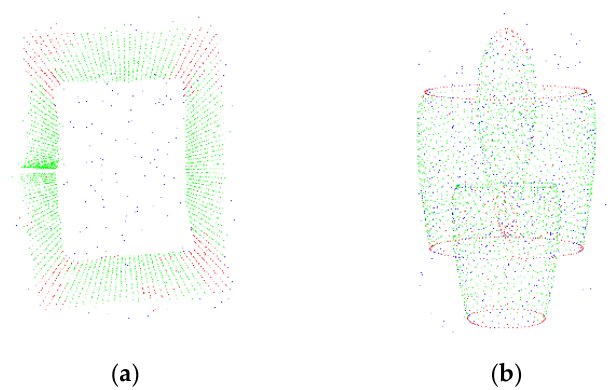
Figure 6. Area segmentation effect in the ( a ) Cube Engine point cloud; ( b ) Engine point cloud.